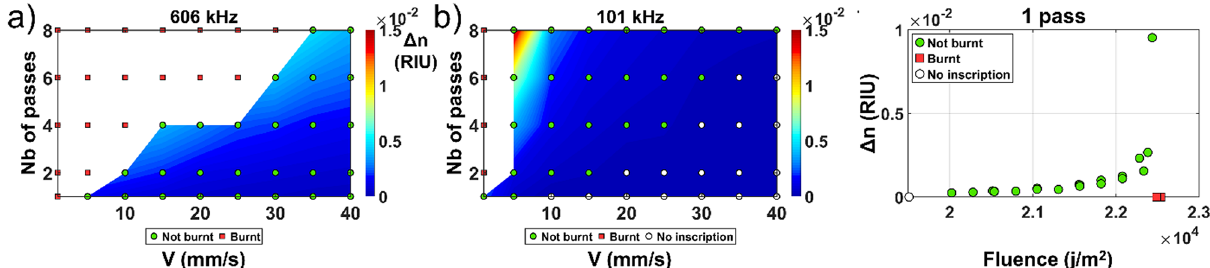
Figure 3. Fs laser induced refractive index change in PDMS-Irgacure-184 for various writing speed and numbers of passes at ( a ) 606 kHz and ( b ) 101 kHz. ( c ) Refractive index change evolution relatively to the fluence for one pass by varying the writing speed and/or the repetition rate incrementally.